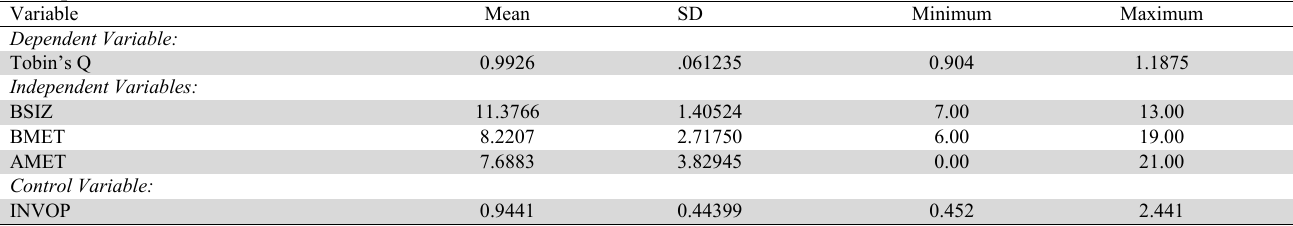
Descriptive statistics